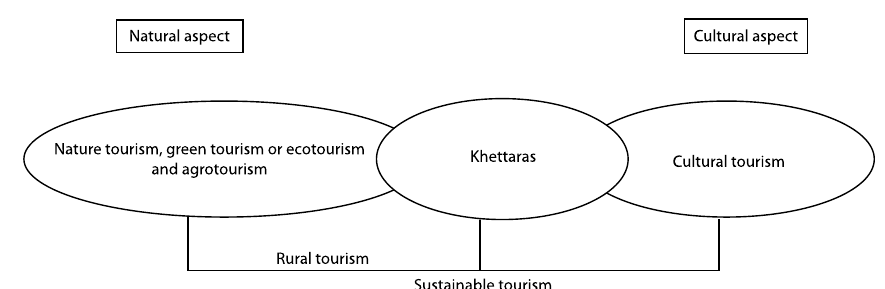
Fig. 9 The contribution of khettaras to different types of tourism (Source: the authors)